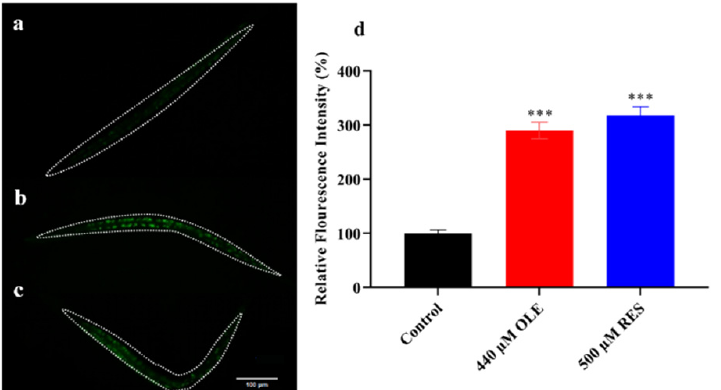
Figure 5. Effect of OLE on sod-3 p::GFP expression. ( a ) Control group; ( b ) OLE treatment group; ( c ) RES treatment group; ( d ) OLE and RES increased the expression of sod-3 p::GFP. Data are presented as relative GFP intensity compared to the control. *** p < 0.001 suggests a significant difference when compared to the control group.